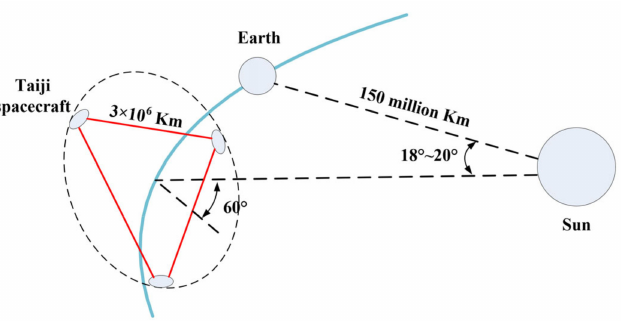
Figure 1. The Chinese Taiji program for space gravitational wave detection.